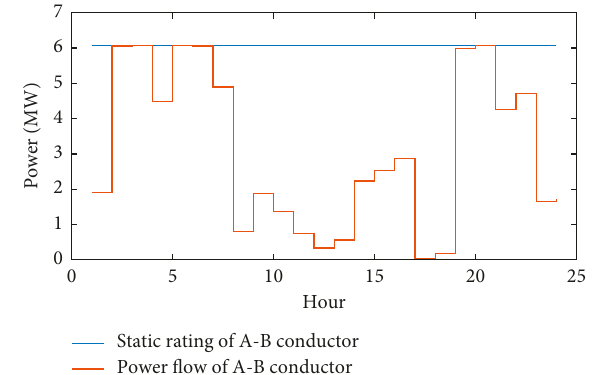
Figure 16: Static power rating of the conductor and the power flow of the conductor when the system is operated at case study 1.